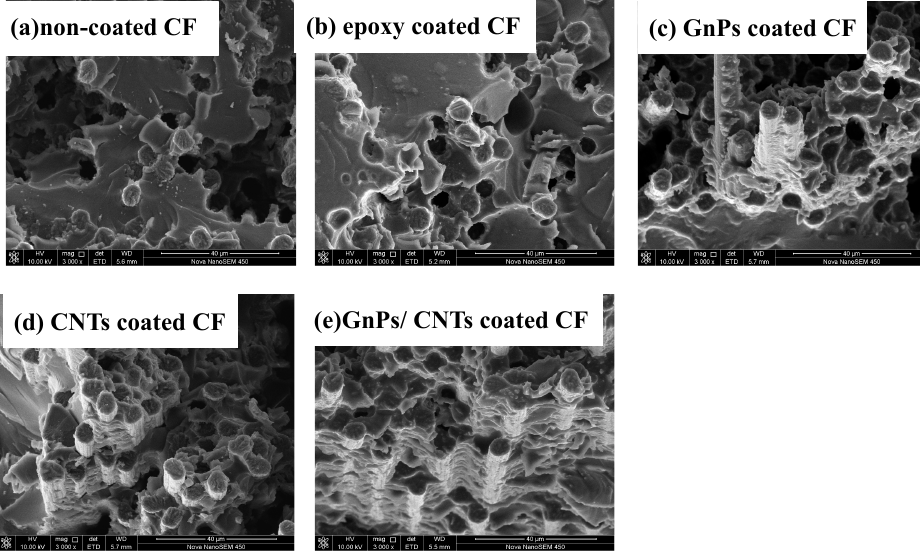
Figure 7. SEM images of fractured surface of CF/EP composites: ( a ) non-coated CF, ( b ) epoxy coated CF, ( c ) GnPs coated CF, ( d ) CNTs coated CF and ( e ) GnPs/CNTs coated CF.